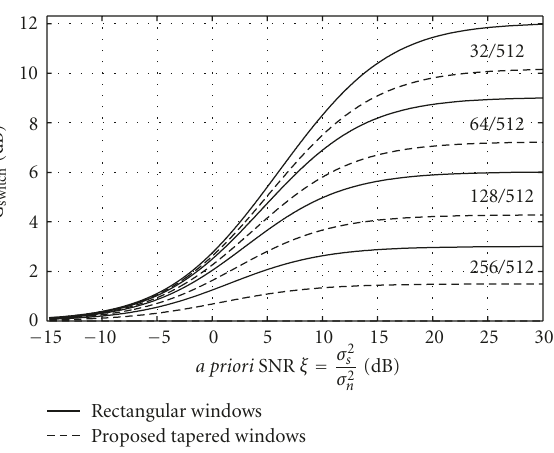
Figure 3: Expected spectral power gain versus a priori SNR ξ for using a short analysis window versus a long window during speech onsets. The curves are labeled with the ratio of the lengths of short and long windows, 2 M/K . The solid line shows the results for rectangular analysis windows, the dashed line the results for the proposed window set. The envelope of the time domain signal is idealized as a step function where the section with increased power coincides with the boundaries of the short Figure 2: Idealized scenario of a speech onset of power σ 2 in noise s . The speech onset coincides with the short spectral of power σ 2 n analysis window (2 M most recent samples). The analysis window is either (a), rectangular, or (b), tapered.